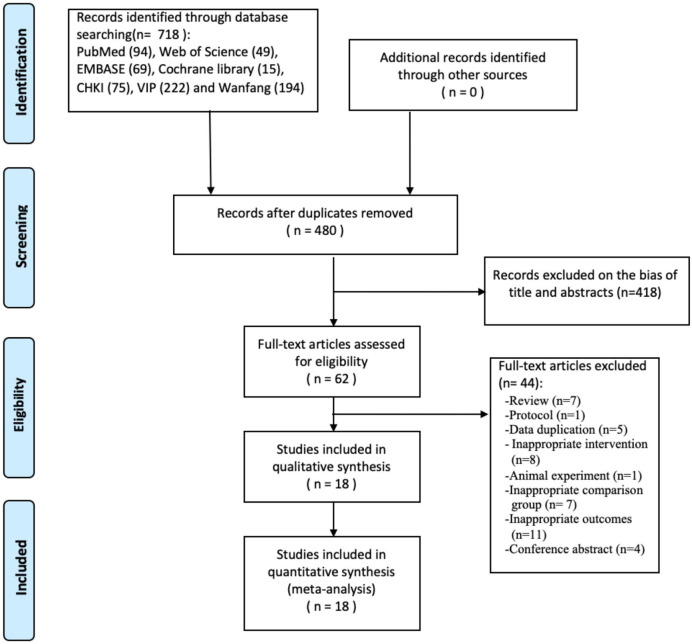
Flowchart of the study selection.